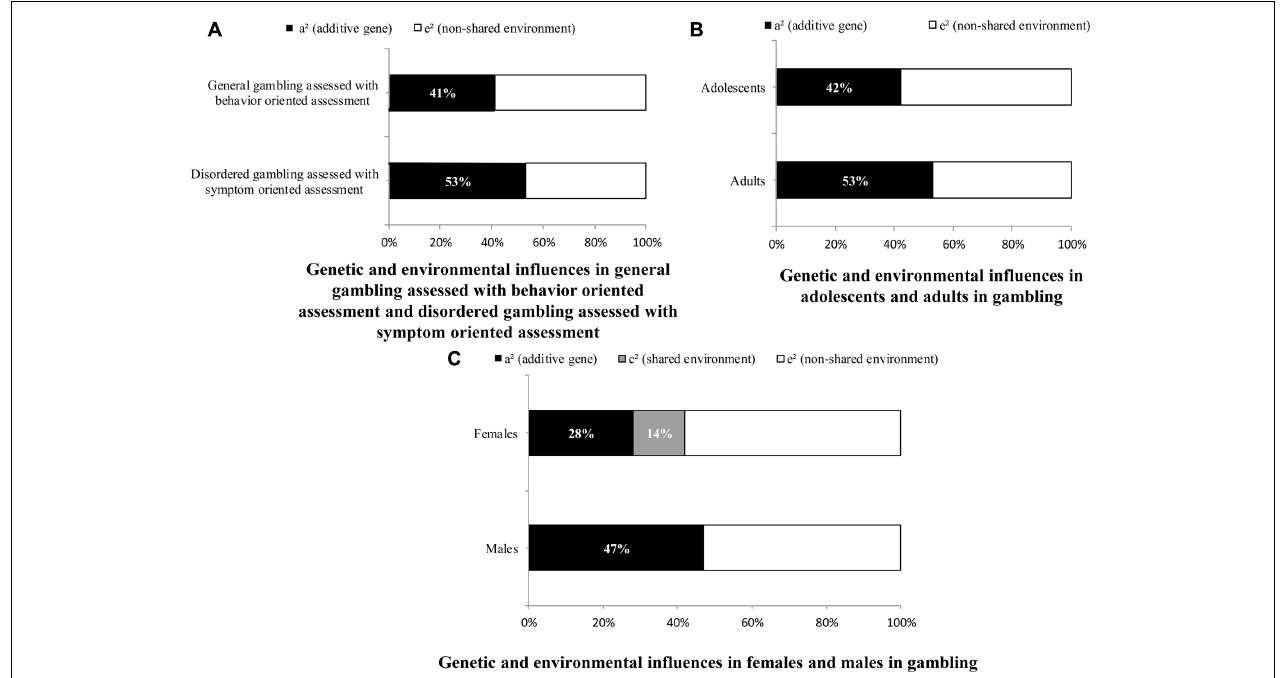
FIGURE 1 | Genetic and environmental influences on gambling. (A) Indicates the proportions of the genetic and environmental influences on disordered gambling assessed with symptom oriented assessment and general gambling assessed with behavior oriented assessment; (B) indicates the relative magnitude of genetic and environmental influences on gambling for adolescents and adults; (C) indicates the relative contribution of genetic and environmental factors on gambling for females and